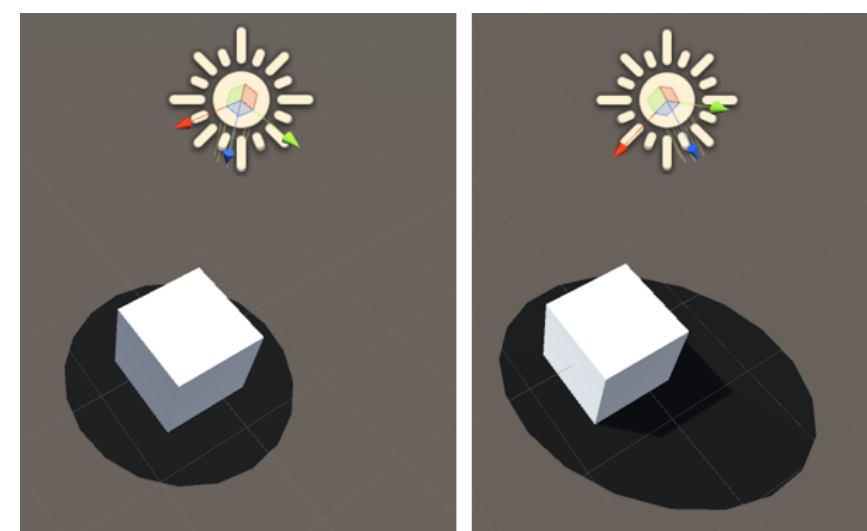
Figure 18. “Floor Object” deformation.